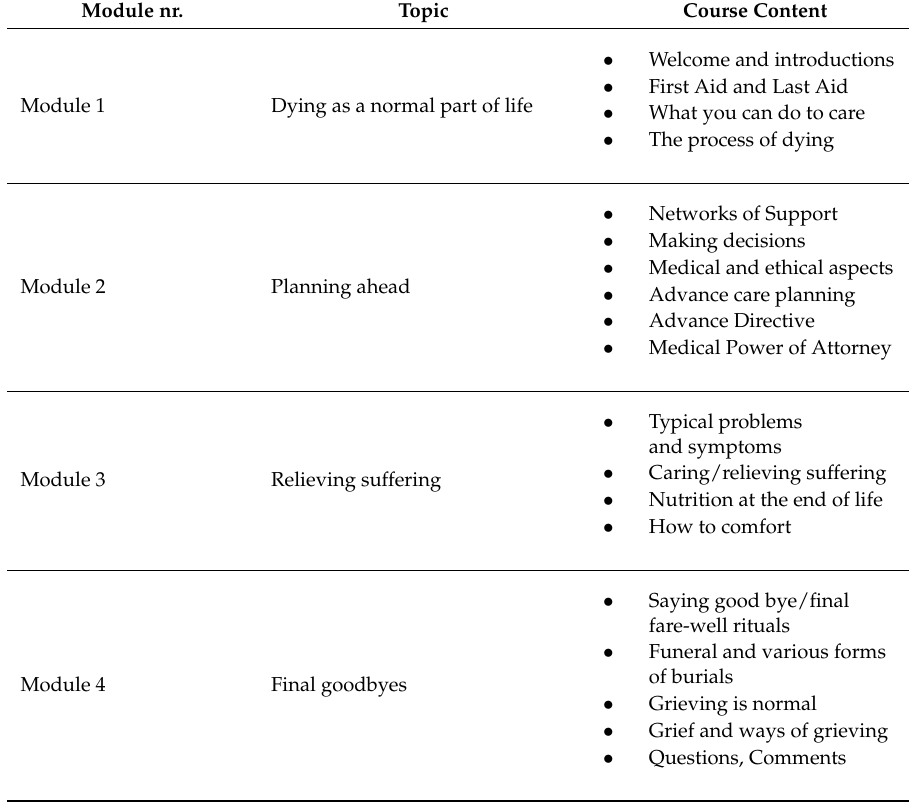
Table A1. The Last Aid course contents (version May 2018). Last Aid Care for seriously ill and dying people at the end of